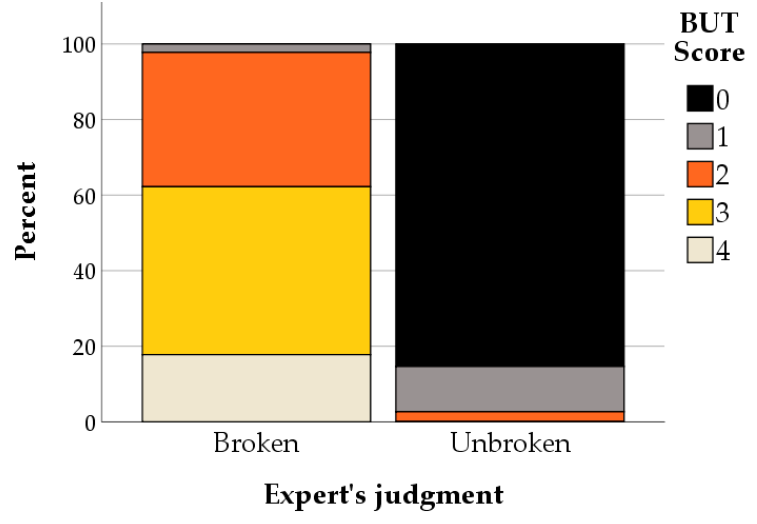
Figure 3. Relative distribution of the main observer’s BUT score according to the expert’s judgment of broken vs. unbroken status.